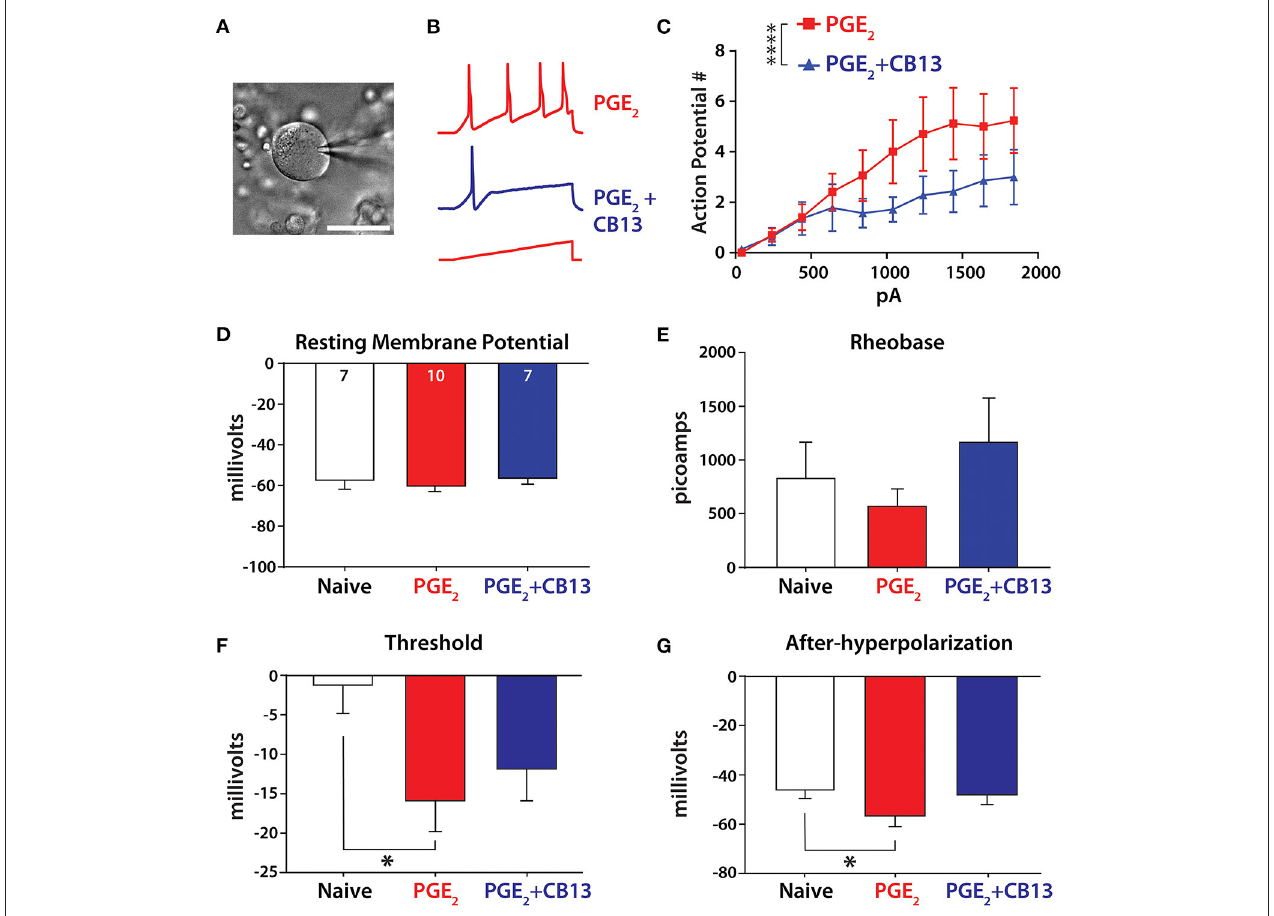
FIGURE 2 | CB13 reduces PGE 2 -induced sensitization of primary sensory neurons. (A) Image of hDRG neuron under patch clamp. Scale bar = 50 µ m. (B) Example traces from PGE 2 and PGE 2 + CB13-treated cells showing action potential discharge. A 500-ms ramp current protocol increased 200pA in each step. (C) Action potential discharge from stepwise increasing current ramp. Two-way ANOVA, p < 0.0001. (D) Resting membrane potential, cell numbers inset. (E) Rheobase determined as the minimum current applied as a 800-ms square pulse-stepped 100pA per cycle to elicit an action potential. (F) Threshold was taken as the point where the first derivative of voltage exceeded 10 V/s on the first action potential from a ramp stimulus. One-way ANOVA with Tukey’s multiple comparisons, p < 0.05. (G) After-hyperpolarization was the most negative voltage reached after an action potential was elicited from a short, 2-ms step protocol. One-way ANOVA with Tukey’s multiple comparisons, * p < 0.05; **** p <